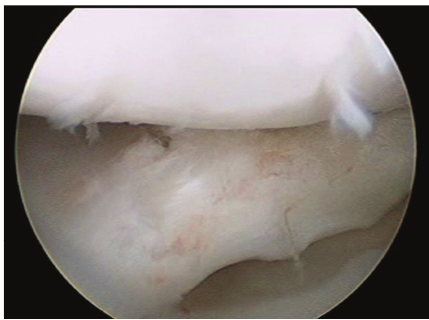
Figure 7: Arthroscopic image of the medial femorotibial compart- ment of the left knee from the anterolateral portal. Medial discoid meniscus shown after saucerization and